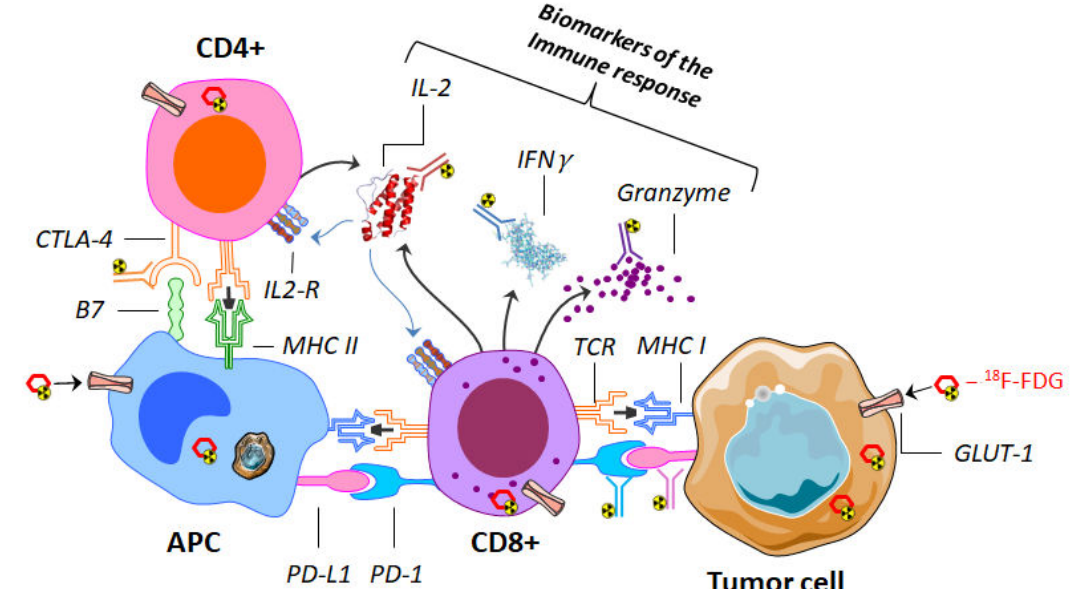
Figure 2. Representation of the interaction between CD4 and CD8 lymphocytes with an antigen-presenting cell (APC) (here a macrophage) and a tumor cell. Di ff erent targets can be imaged by use of several labeled antibodies (immuno-PET). These targets may be immune-checkpoints (such as cytotoxic T-lymphocyte antigen 4 (CTLA-4), PD-L1, and its receptor programmed cell death protein-1 (PD-1)) or biomarkers of the immune response (such as interferon γ (IFN γ ), granzyme and interleukin-2 (IL2)). 18 F-fluorodeoxyglucose (18F-FDG), on the other hand, makes it possible to assess the expression of the glucose transporter (GLUT-1); it can be incorporated indi ff erently, both in tumor and immune cells. PET: positron emission